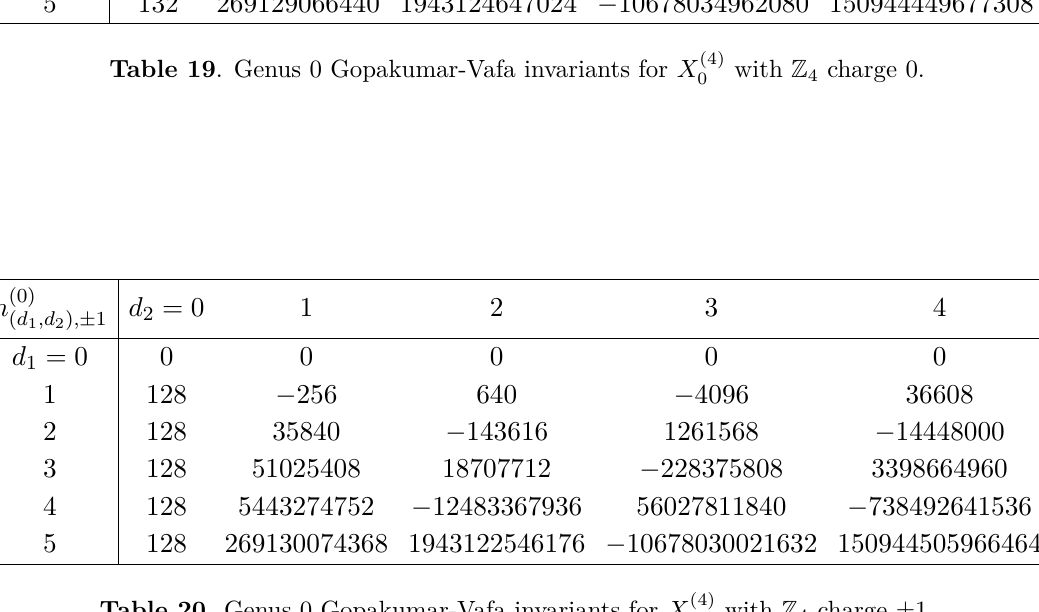
Table 20 . Genus 0 Gopakumar-Vafa invariants for X (4)